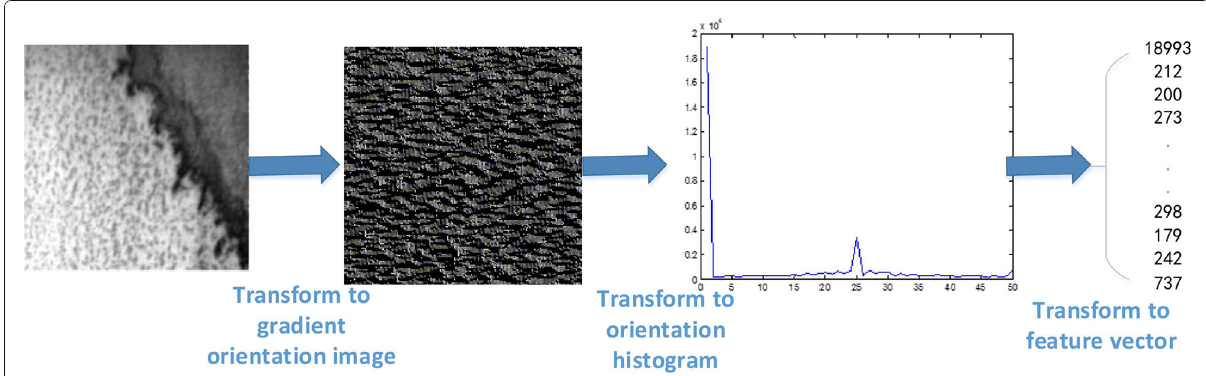
Fig. 3 Process to convert defect image to HOG feature